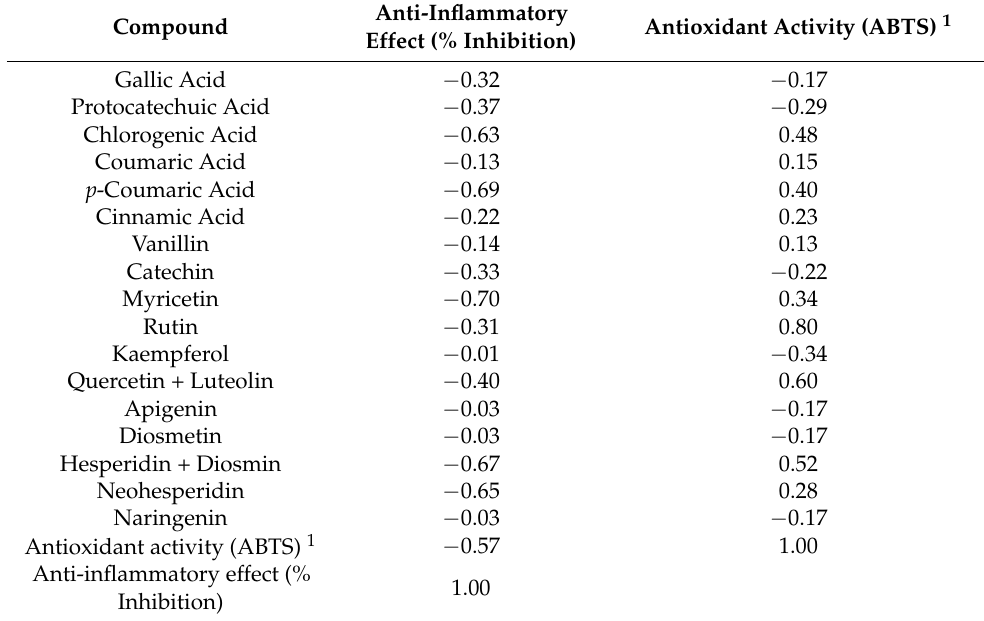
Table 5. Correlation matrix (Pearson correlation coefficient) performed on data obtained from extracts of leaves of C. chinense grown on black soil and stems of plants grown on black and red soils obtained by ME, SOX and SFE. Anti-Inflammatory Compound Antioxidant Activity (ABTS) 1 Effect (% Inhibition) Gallic Acid − 0.32 − 0.17 Protocatechuic Acid −